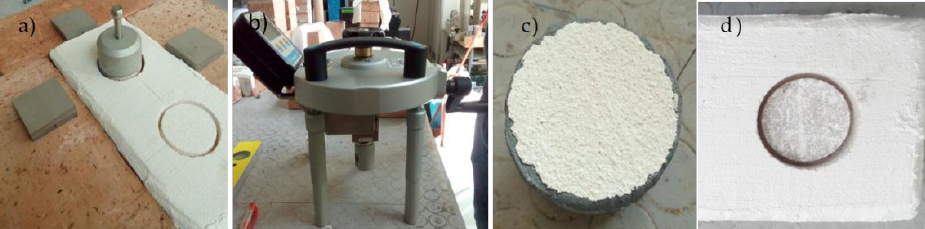
Figure 3. ( a ) Sample with steel cylinders connected to the instrument for the measurement of adhesion strength; ( b ) tear-off-adhesive tester; ( c ) steel cylinders after test; ( d )sample after test.